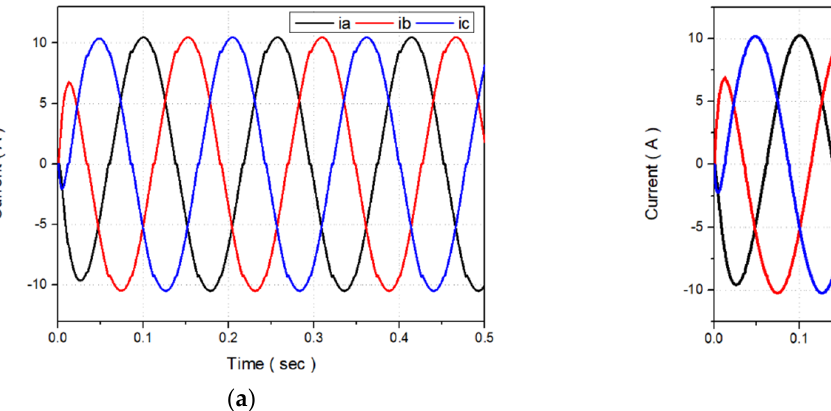
Figure 18. Three − phase stator current waveform during DTC torque control. ( a ) Scenario with no compensation for disturbance voltage generated during the dead time. ( b ) Scenario when the disturbance voltage generated during the dead time is compensated using a disturbance observer.